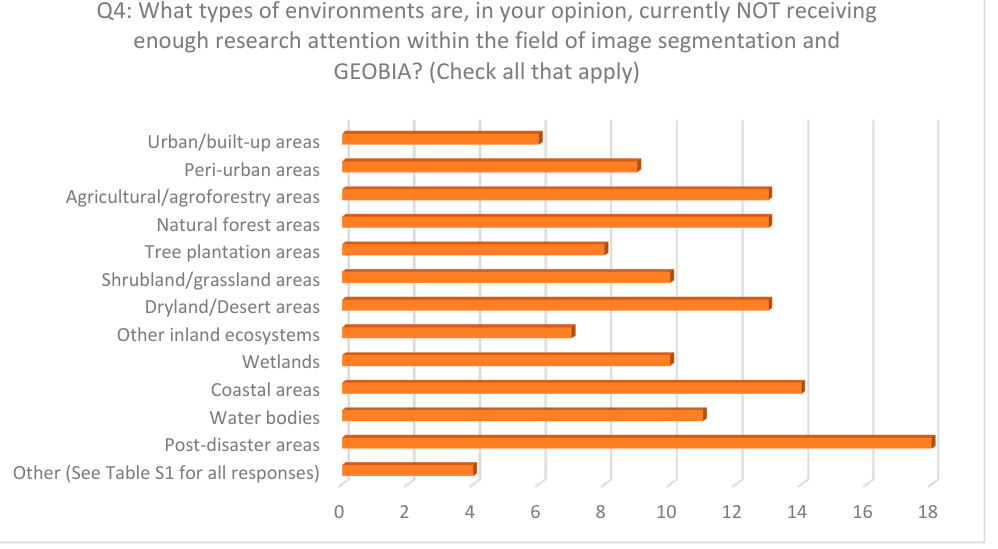
Figure 5. Responses to question 4 (Q4) of the online survey.